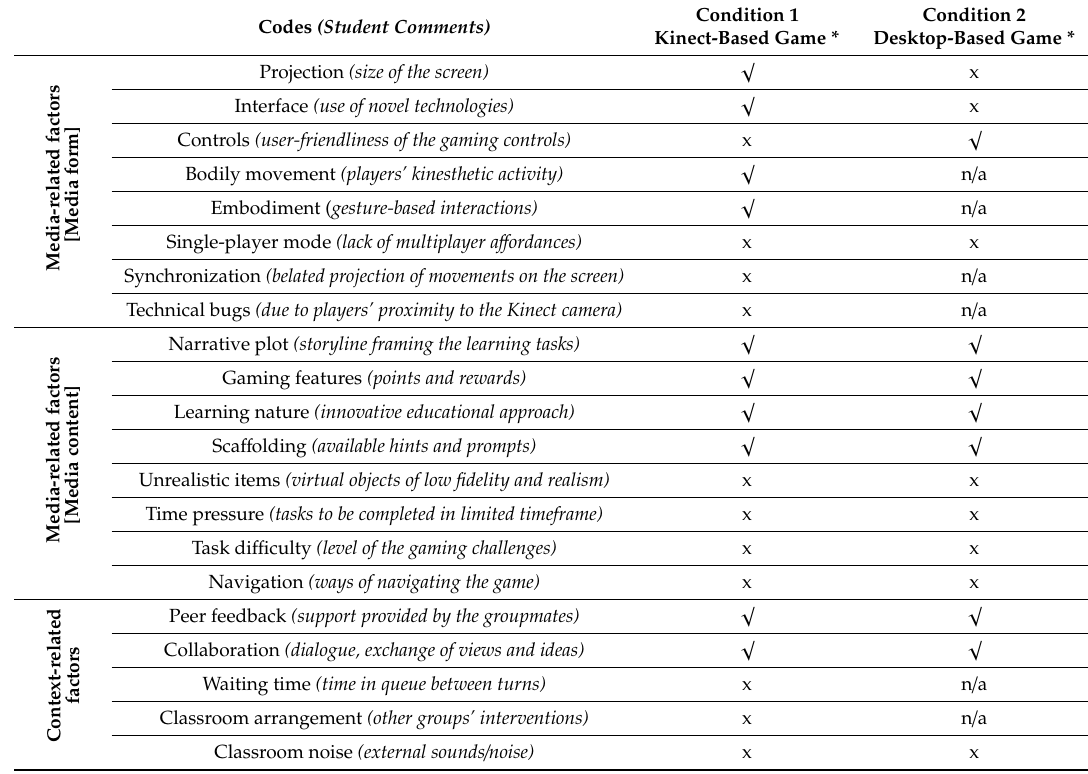
Table 5. Factors a ff ecting experienced